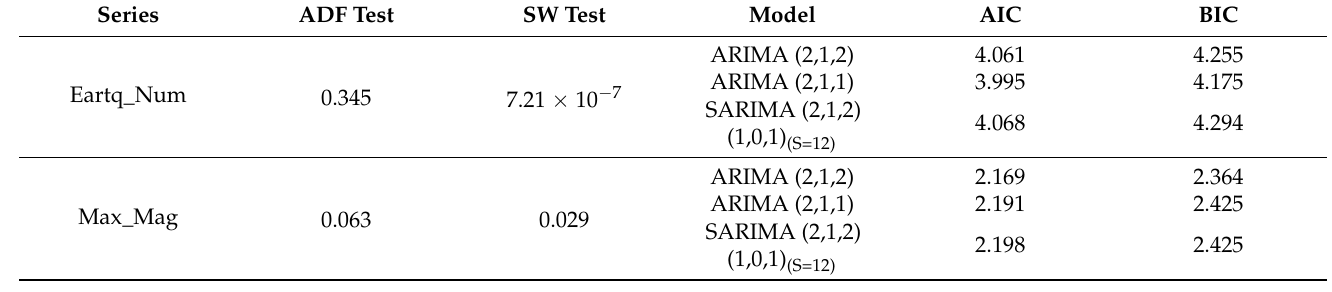
Table 1. Annual earthquake number and annual maximum magnitude time series stationarity (ADF) and normality (SW) tests results. ARIMA model selection using the AIC and BIC criterions are also showed.